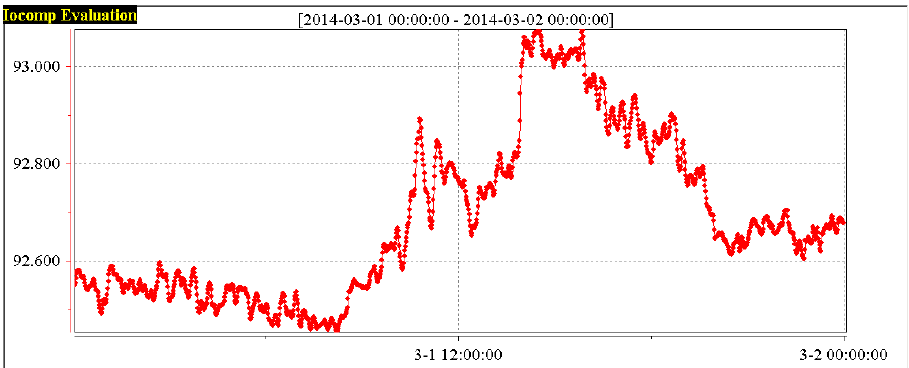
Figure 3. The boiler thermal efficiency x 1 (%) (1# boiler).